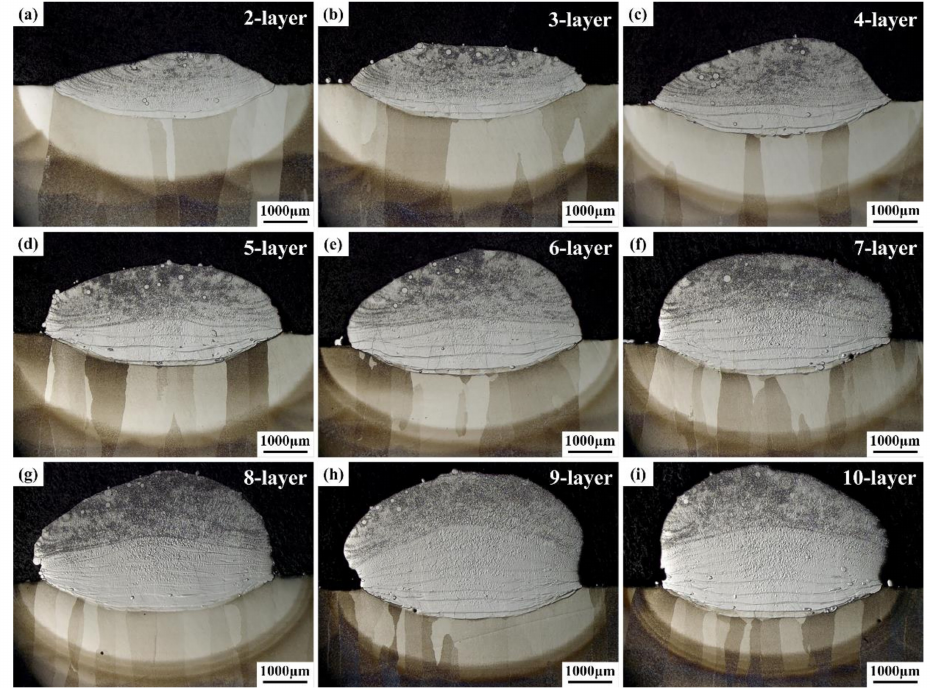
Figure 4. Cross-sections of multiple-layer samples on TA15 substrate: ( a ) the two deposited layers; ( b ) the three deposited layers; ( c ) the four deposited layers; ( d ) the five deposited layers; ( e ) the six deposited layers; ( f ) the seven deposited layers; ( g ) the eight deposited layers; ( h ) the nine deposited layers; ( i ) the ten deposited layers.